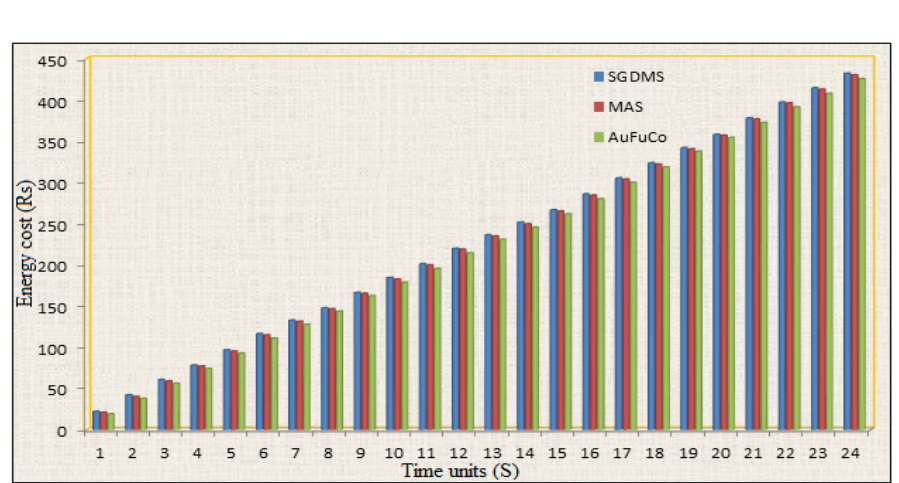
Figure 25. Comparison of present energy cost variation.